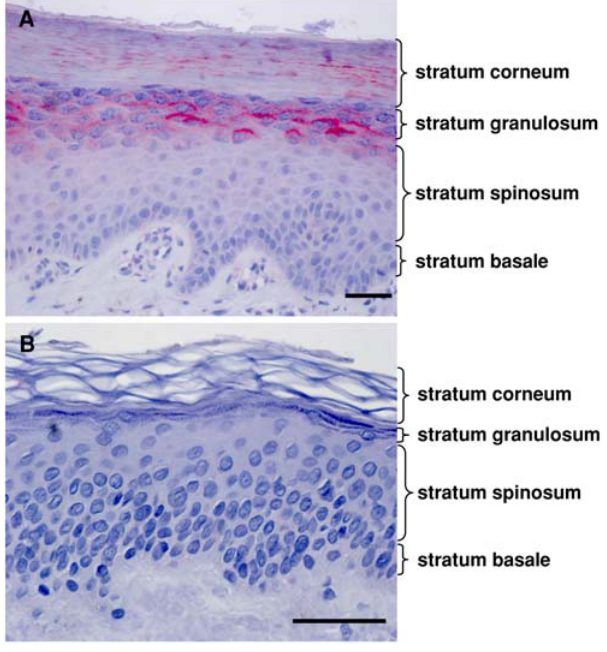
Figure 5. LEKTI-2 is expressed at palmar and plantar sites. Immunohistochemical staining (Vector red) of LEKTI-2 of paraffin- embedded human skin samples using polyclonal antibodies. Only palmar and plantar localizations (A, n=8) exhibited obvious LEKTI-2 immunoreactivity at the stratum granulosum and stratum corneum. Other localizations (e.g. trunk, B, n=16) did not reveal LEKTI-2 immunoreactivity. Bars indicate 50 m m.